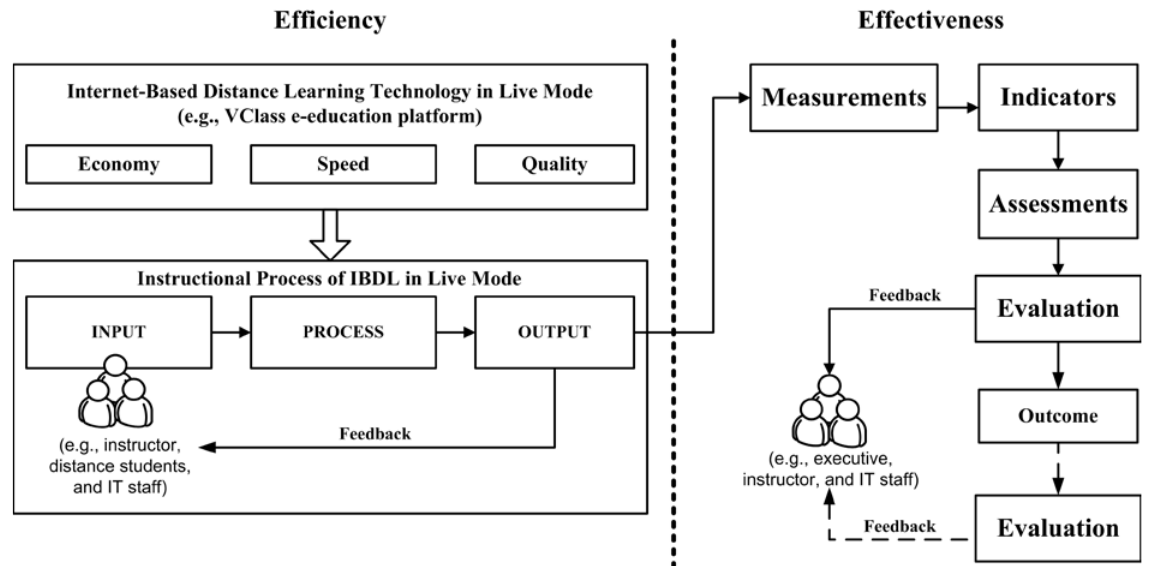
Figure 2. Evaluation process for IBDL through